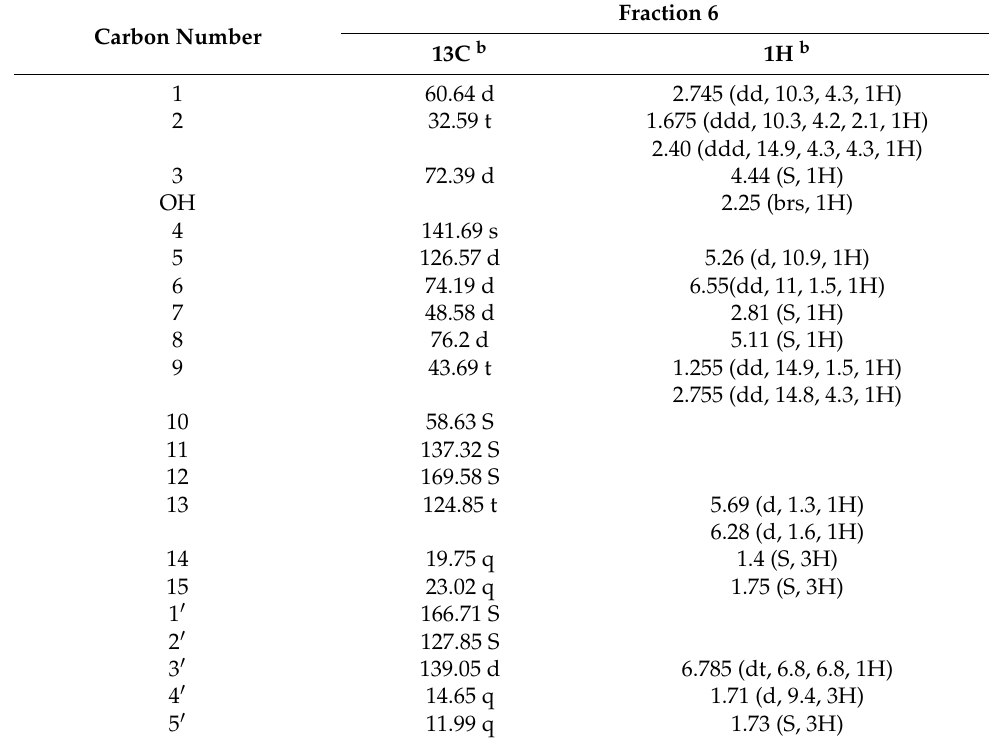
Table 2. The 1 H-NMR and 13 C-NMR chemical shifts of fraction 6 ( δ in